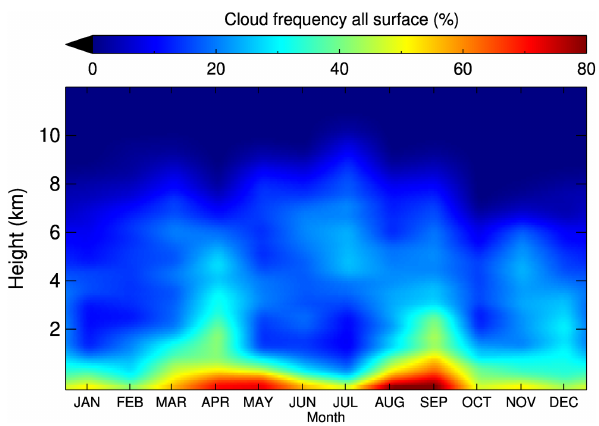
Figure 4. Mean cloud vertical distribution from the surface obser- vations from October 1997 to October 1998 during the SHEBA ex-